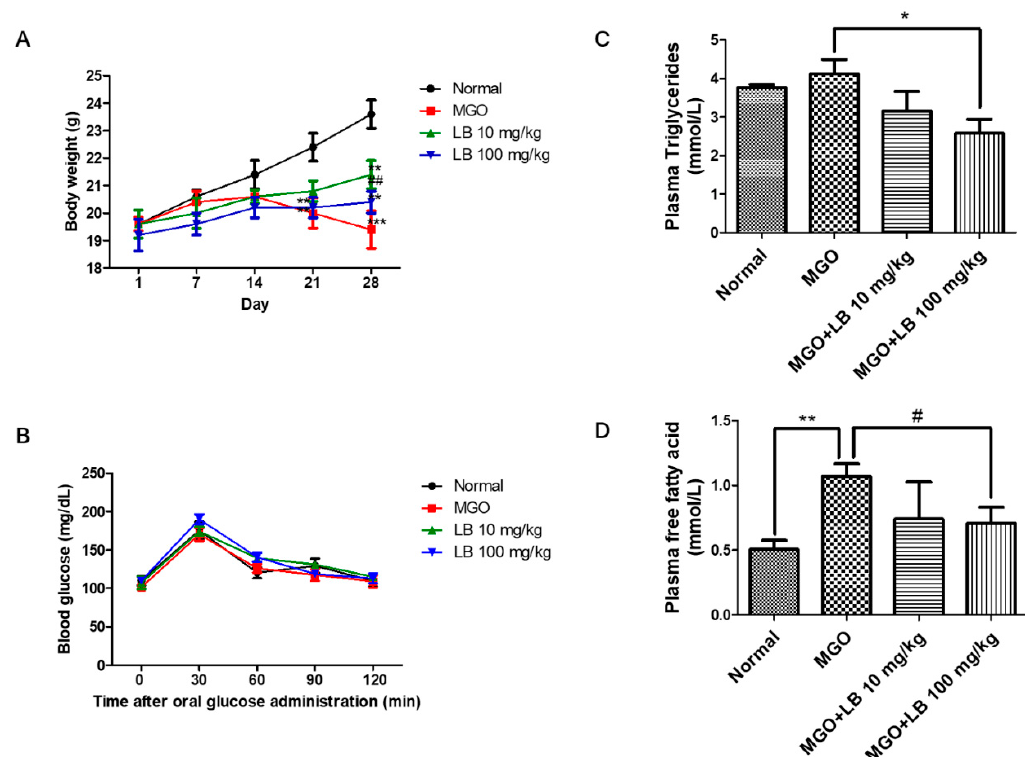
Figure 3. The effect of LB on MGO-induced increase of the plasma lipid profile. ( A ) BW of the experimental mice. ( B ) The results of OGTT (0 − 120 min) performed on the MGO-treated mice. ( C ) The plasma triglyceride levels of the MGO-treated mice. ( D ) The plasma levels of free fatty acids in the MGO-treated mice. The values represent the mean ± SEM (## p < 0.01 and ### p < 0.001 vs. MGO treatment, and ** p < 0.01 vs. the control).